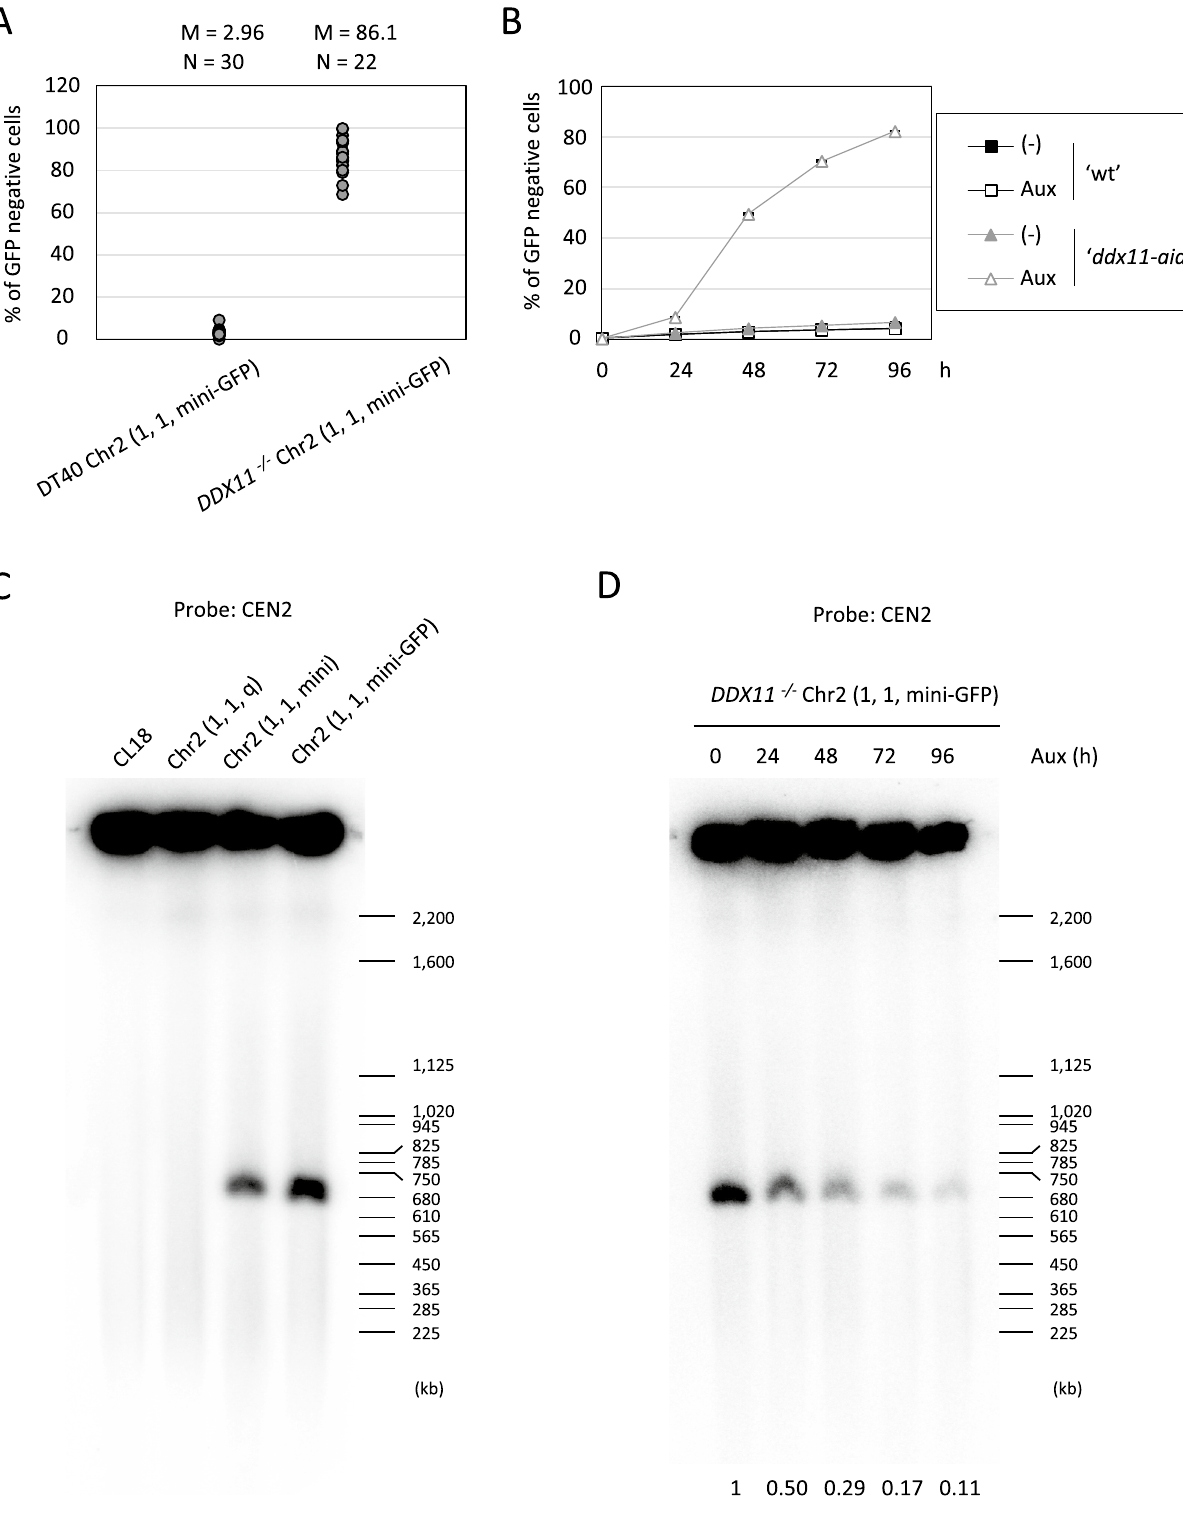
Figure 6. Elevated level of mini-chromosome loss in DDX11 deficient cells. ( A ) DT40 Chr2 (1, 1, mini-GFP) and DDX11 −/− Chr2 (1, 1, mini-GFP) cells were preincubated with puromycin for 24 h. Then, puromycin was washed out, and the cells were inoculated in 96-well plates by limiting dilution. Each clone from single cell was analyzed by flow cytometer 7 days after the limiting dilution. The percentages of GFP negative cells were plotted by excluding clones with 100% cells losing GFP due possibly to loss of mini- chromosome at day 0 in the beginning of the growth from single cell. ( B ) DT40 Chr2 (1, 1, mini-GFP) + TIR1-9myc cells (shown as ‘wt’) and DDX11 3AID−6FLAG/3AID−6HA Chr2 (1, 1, mini-GFP) + TIR1-9myc cells (shown as ‘ ddx11-aid ’) were preincubated with puromycin for 24 h. Then, puromycin was washed out, and the cells were cultured for 4 days in the presence or absence of Auxin. Cells were analyzed by flow cytometer at indicated time points. Error bars show the SD of the mean for 3 independent cultures. ( C , D ) PFGE analyses were performed to detect chromosome 2 driven mini-chromosome. The intensity of band corresponding to mini- chromosome was normalized by that in wells. The scores below the image show the ratios to time